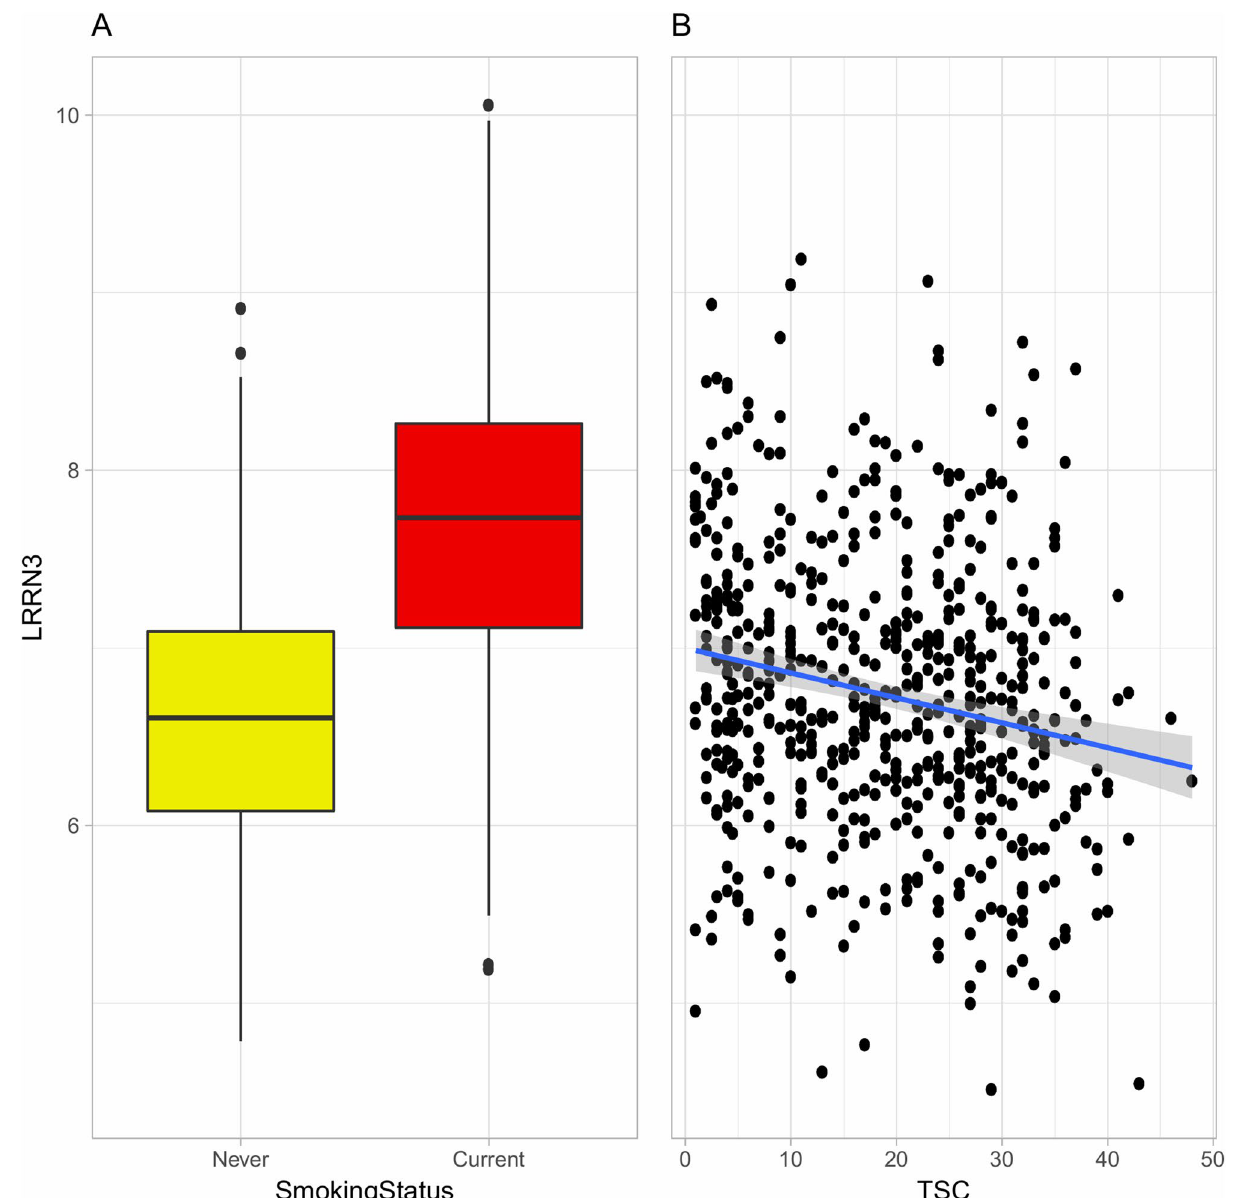
In figure ( A ), boxes extend from the 25th to the 75th percentile, horizontal bars represent the median, whiskers extend 1.5 times the length of the interquartile range above and below the 75th and 25th percentiles, respectively, and outliers are represented as points. In figure ( B ), the blue line represents the linear regression fit and the shaded grey area its standard